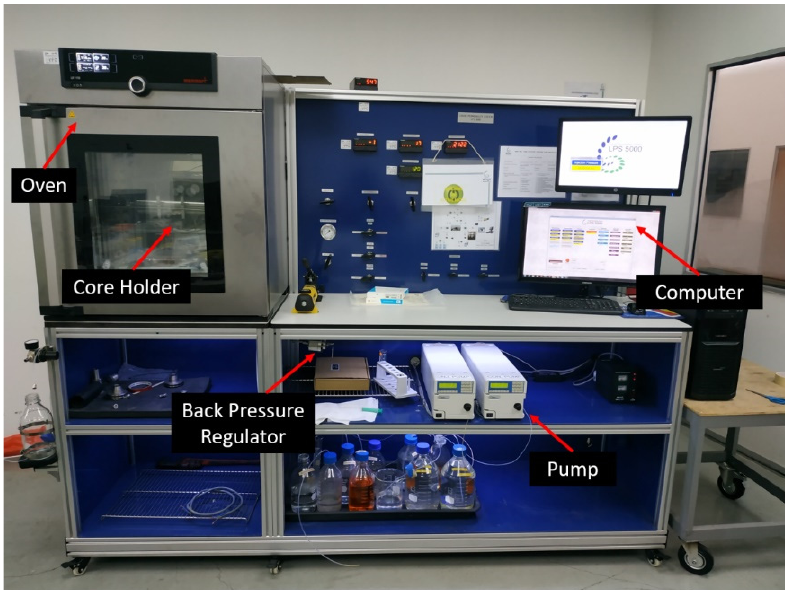
Figure 4. Photo of the coreflooding set-up.